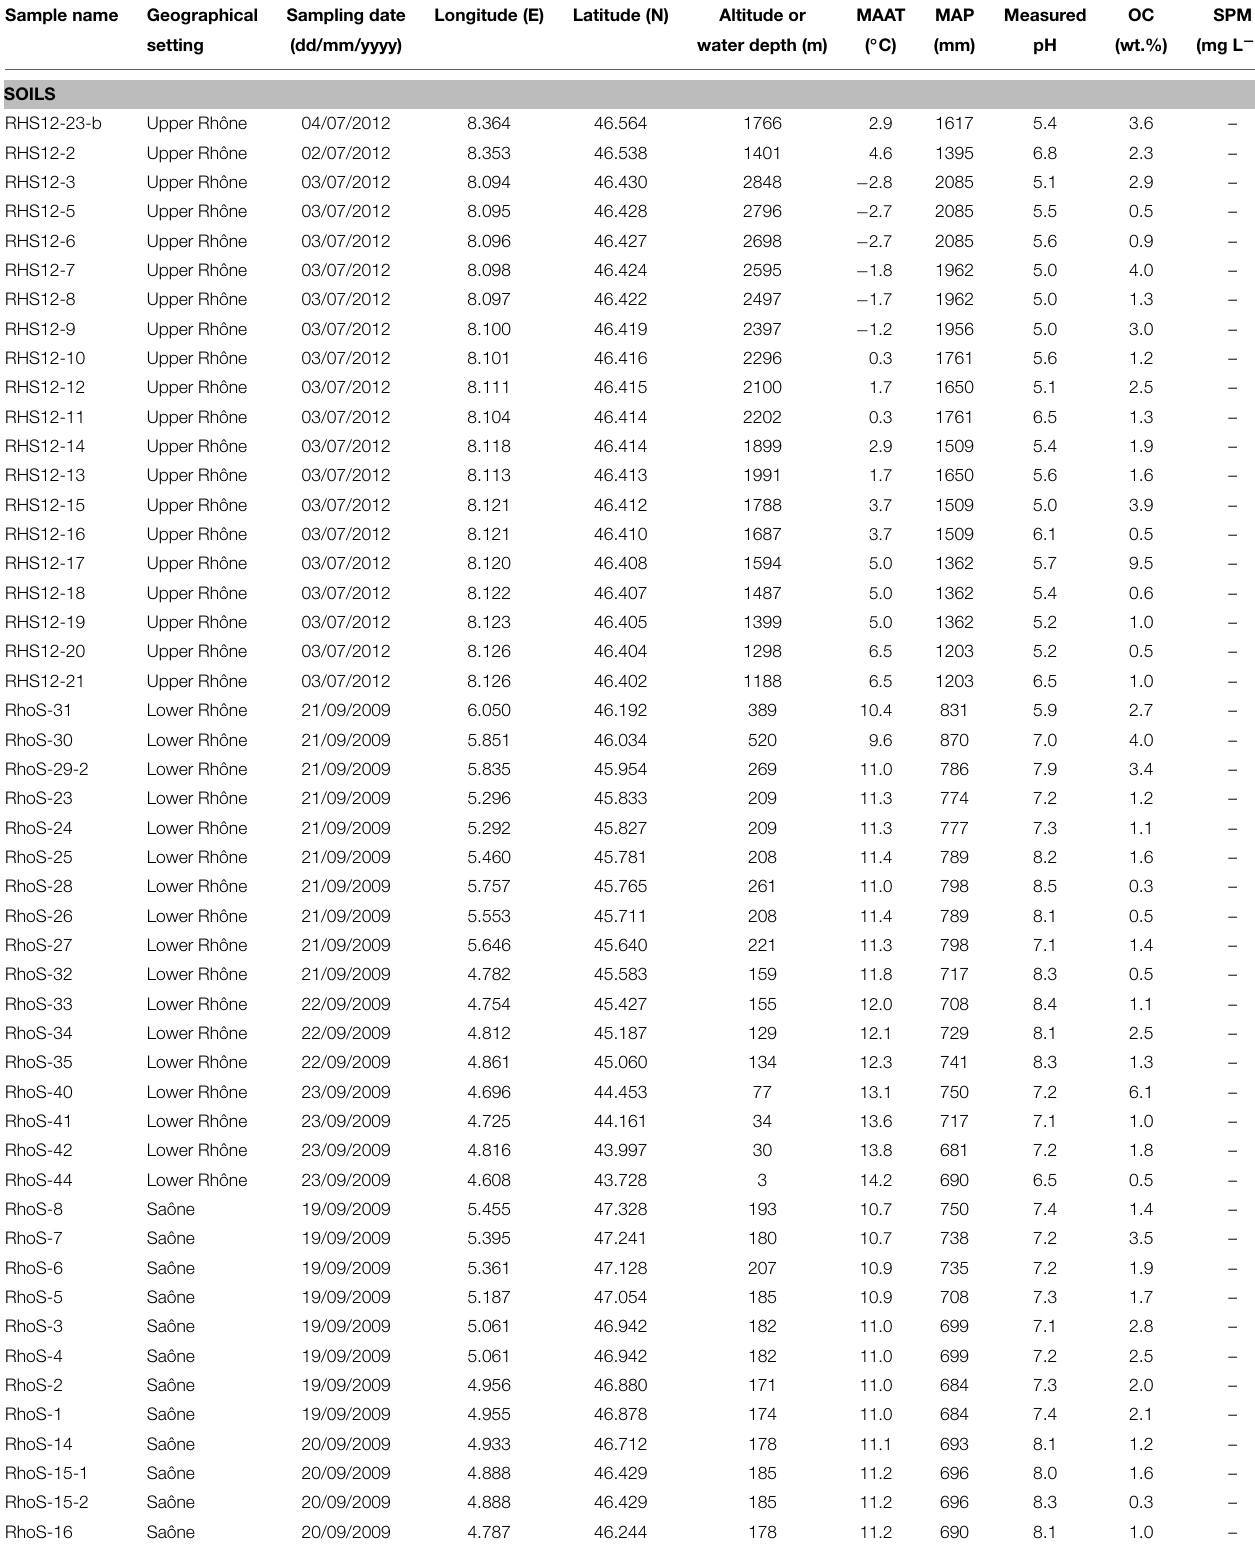
TABLE 1 | Environmental and bulk geochemical data of soils and river SPM collected in the Rhône River and its tributary basins and marine surface sediments collected in the Rhône prodelta (Gulf of Lions, NW